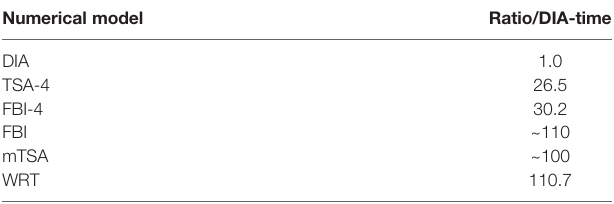
TABLE 4 | Computational ef fi ciency for the simulation of nonlinear interactions S nl . In this comparison, FBI is the full Boltzman integration representation of nonlinear interactions as used in earlier studies like Resio and Perrie (2008). Numerical